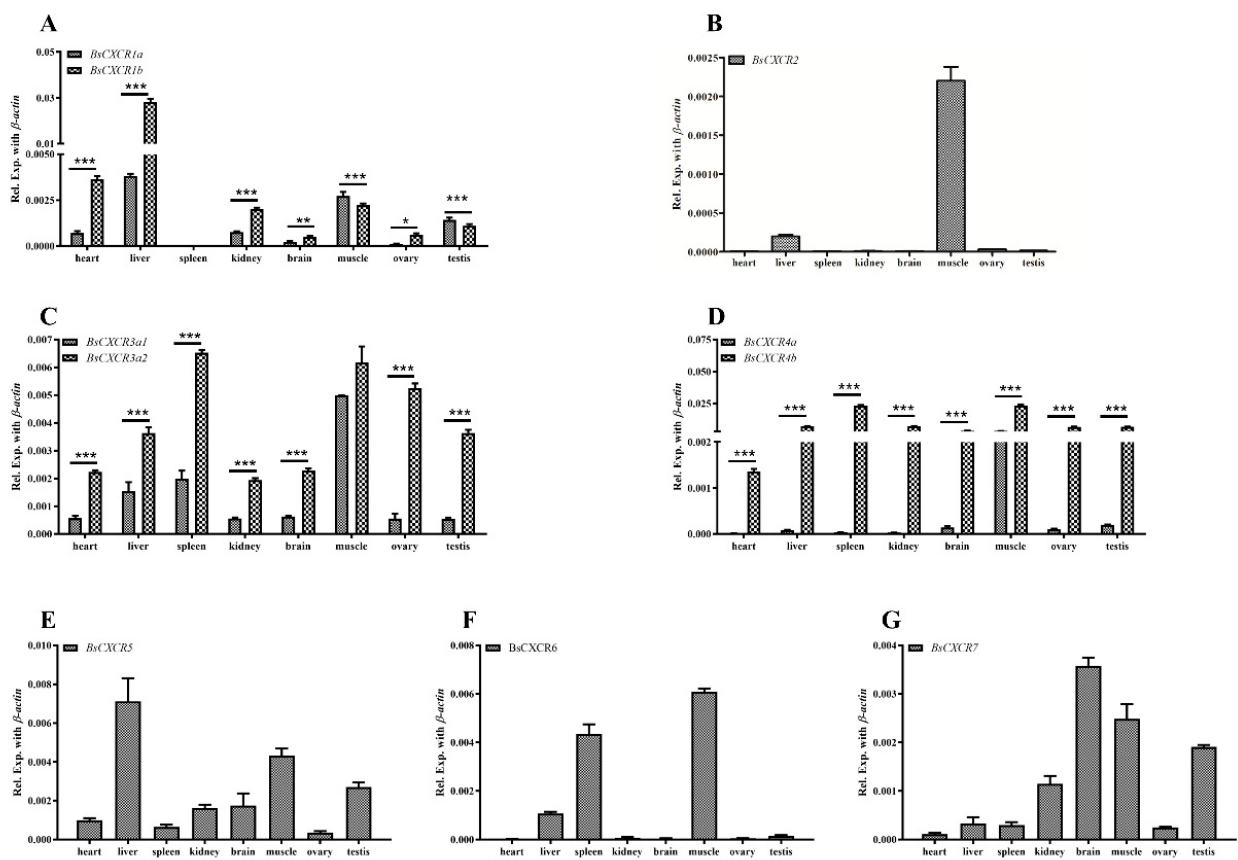
Figure 8. Distribution of BsCXCR transcripts in adult four-eyed sleeper tissues. Quantitative RT-PCR (qRT-PCR) analysis of BsCXCR transcripts in eight adult tissues. ( A ) BsCXCR1a/1b , ( B ) BsCXCR2 , ( C ) BsCXCR3a1/3a2 , ( D ) BsCXCR4a/4b , ( E ) BsCXCR5 , ( F ) BsCXCR6 , ( G ) BsCXCR7. Each bar represents mean ± SD (n = 3). The asterisks indicate the significant differences between two groups (* p < 0.05; ** p < 0.01; *** p < 0.001).